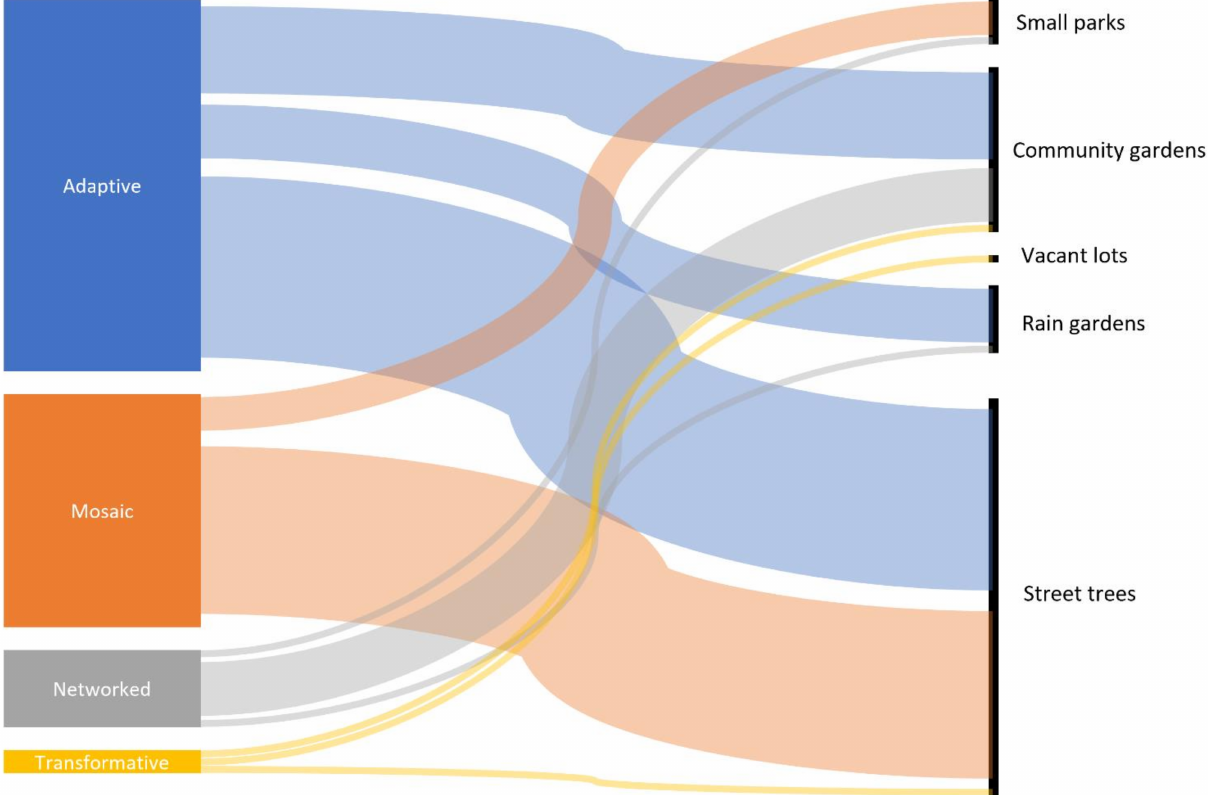
Figure 4. Sankey diagram showing the link of governance modes and UGI types. The thickness of each band corresponds to the number of studies involving the